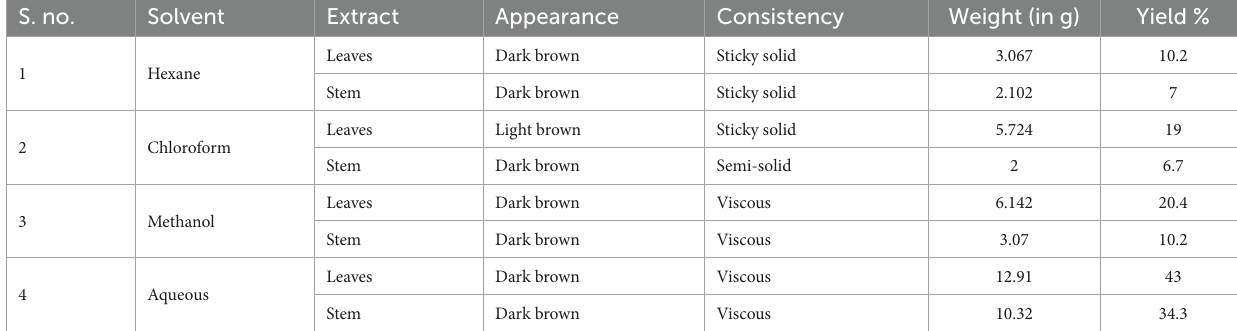
TABLE 1 Physical characteristics, weight of solvent and the percentage yield of plant material. S.